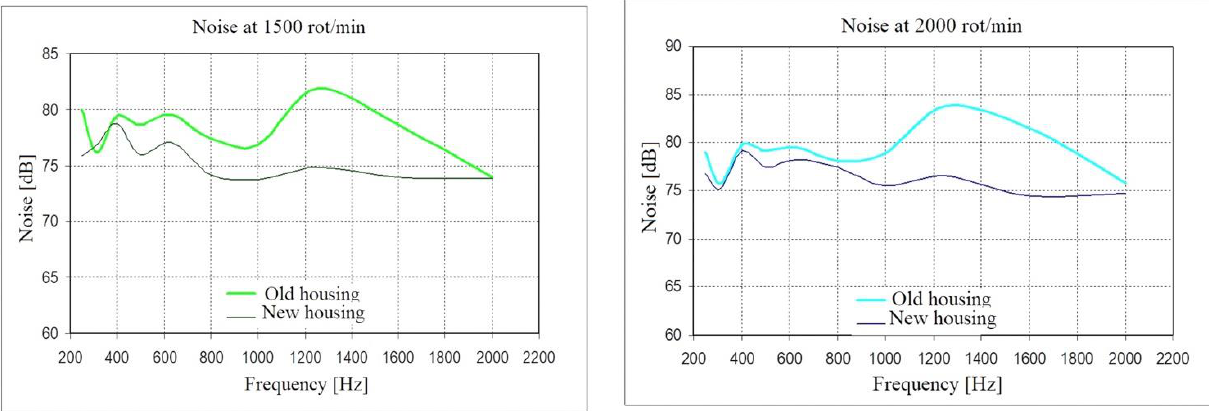
Figure 37. Lp sound pressure level diagrams for right side surface at 1500 and 2000 rpm.